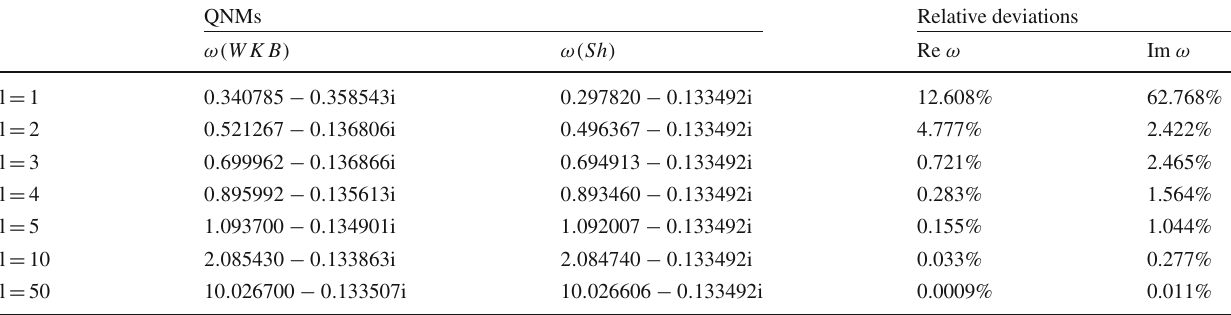
Table 11 The QNMs derived by the WKB approximation approach and shadow radius and the relative deviations. In the calculation, we let Q = 1 and α = − 2